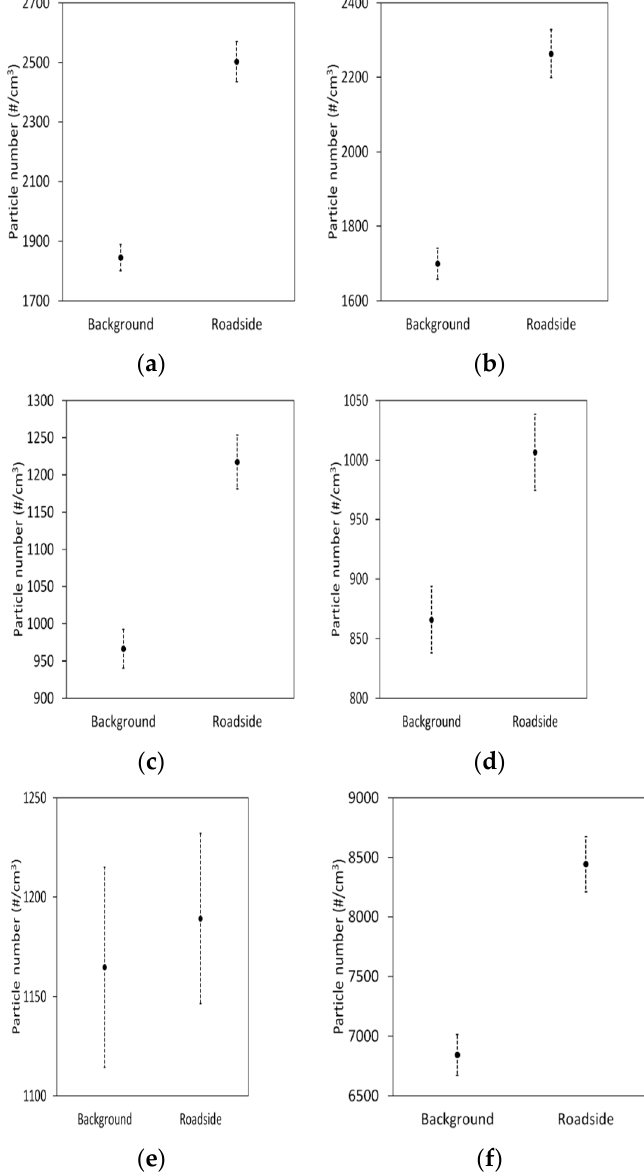
Figure A2. Statistical comparison of ultrafine particle number concentration averages (with a 95% confidence interval) for ( a ) N (20–30 nm); ( b ) N (30–50 nm); ( c ) N (50–70 nm); ( d ) N (70–100 nm); ( e ) N (100–200 nm) and ( f ) PNC.